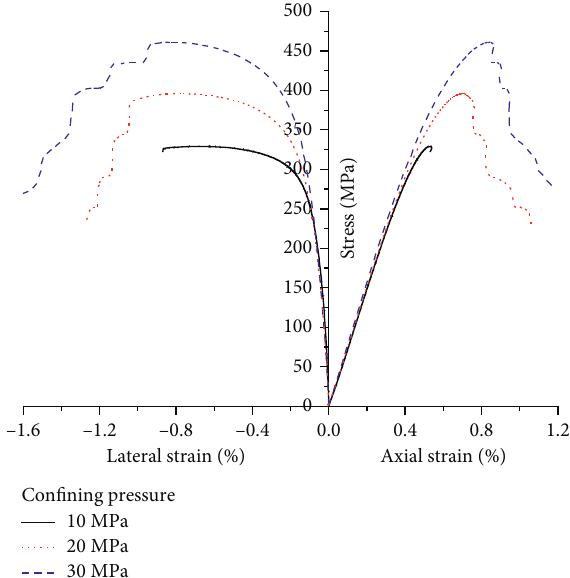
Figure 6: Stress-strain curves under three different confining pressures.